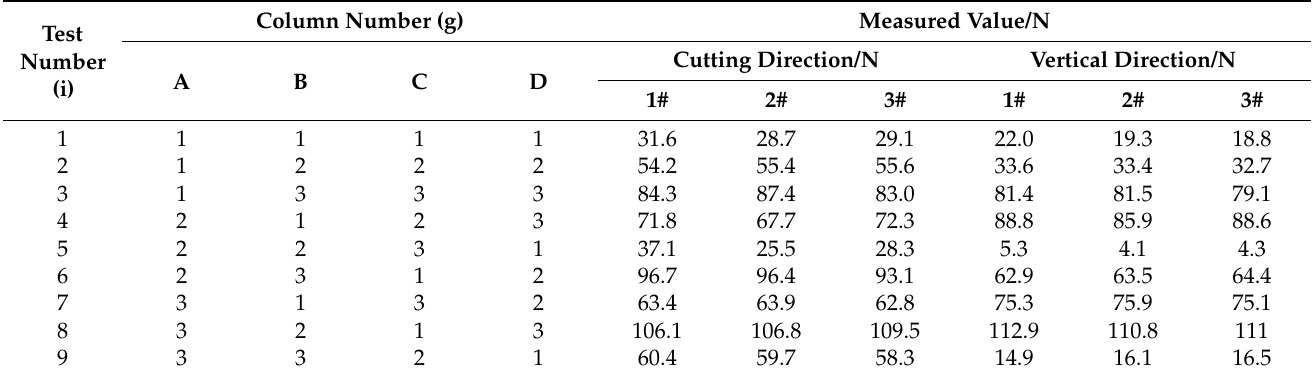
Table 3. Orthogonal test design and measurement